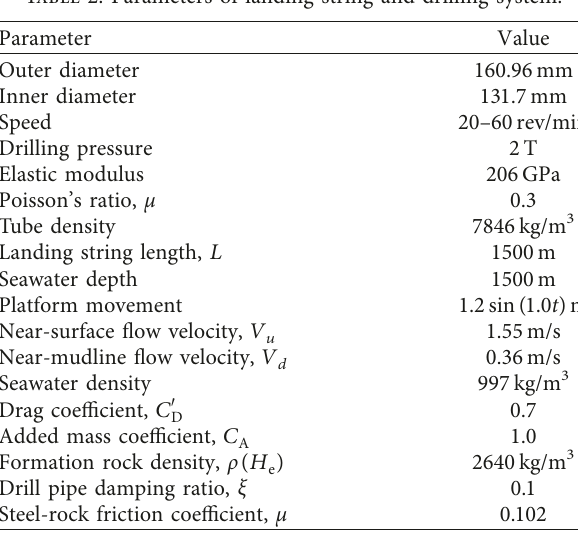
Figure 5: Time history responses of (a) longitudinal and (b) transverse displacements of the middle section of the standpipe in case Table 2: Parameters of landing string and drilling system.